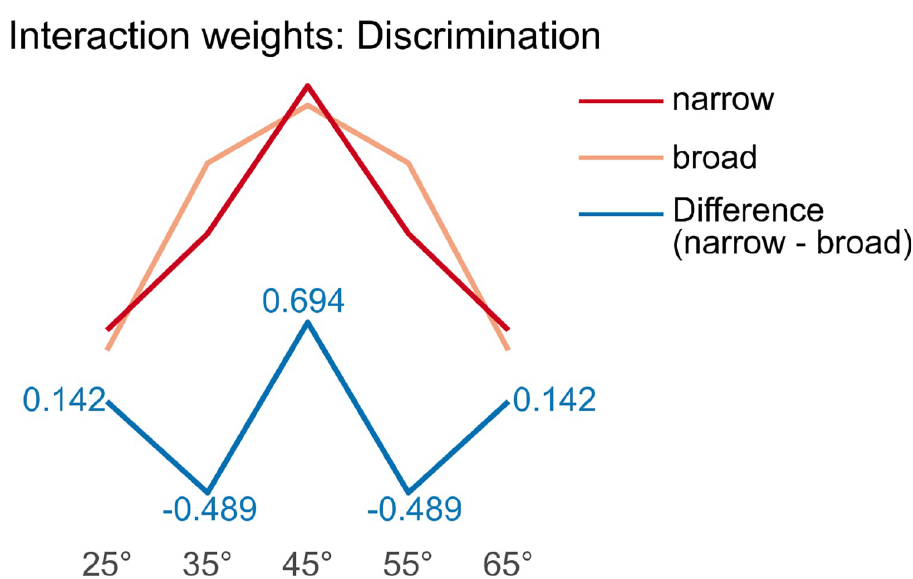
Fig 2. Contrast weights of Mexican hat for the orientation x synchronization interaction. Contrast weights for the expected discrimination to test the synchronization × orientation interaction in the theta-band. The weights shown for a narrow (red) and broad (orange) generalization pattern are examples that if subtracted (narrow–broad) produce the exact discrimination weights we used for the group × orientation interaction contrast (numbers in black font, 0.142, − 0.498, 0.694, − 0.498, 0.142; [20]), resembling a Mexican Hat (blue line).